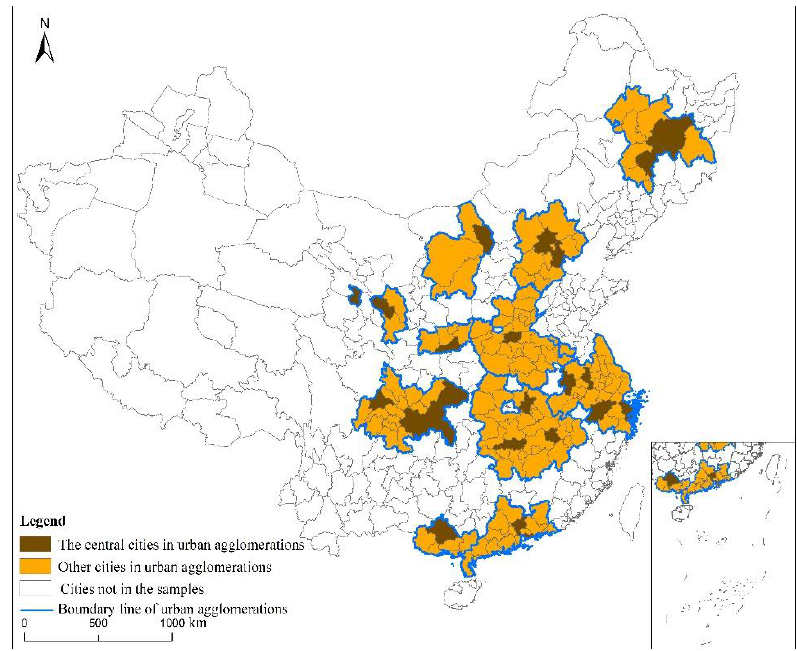
Figure 2. Samples. Figure 2.